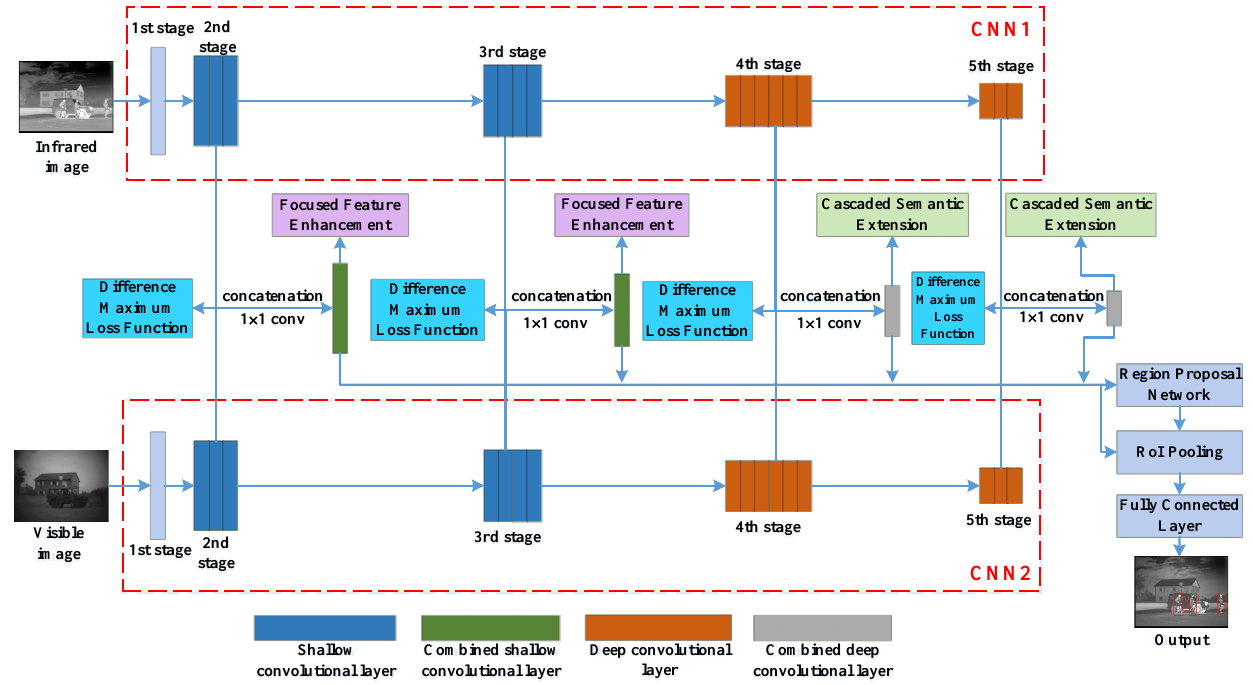
Figure 1. The pipeline of the proposed infrared and visible image object detection